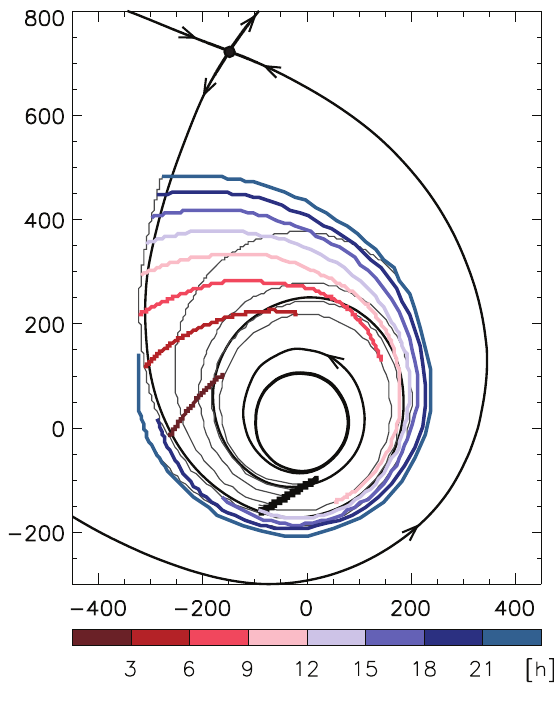
Fig. 6. Backward trajectories at 2km seeded along a line segment (thick black line south of the center) approximating the central area of the downdraft region shown in Fig. 5. The colors denote the time it takes to reach the downdraft region. The thin lines exemplify some individual streamlines. The horizontal scale is in